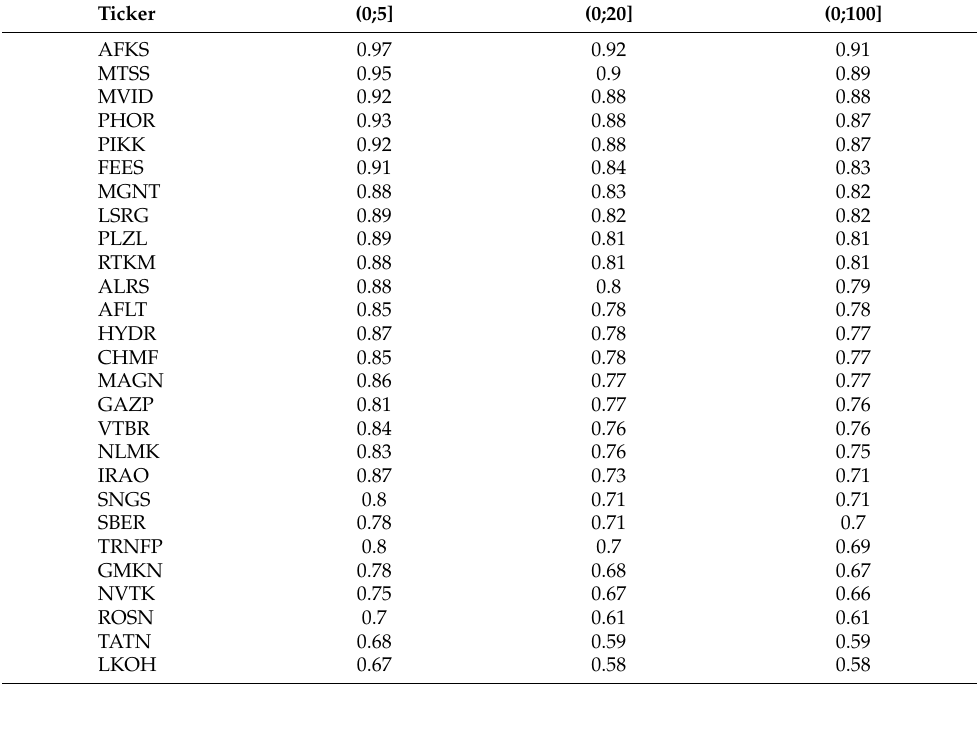
Table A2. Mean square error ratio of the h-step forecast for full sample.